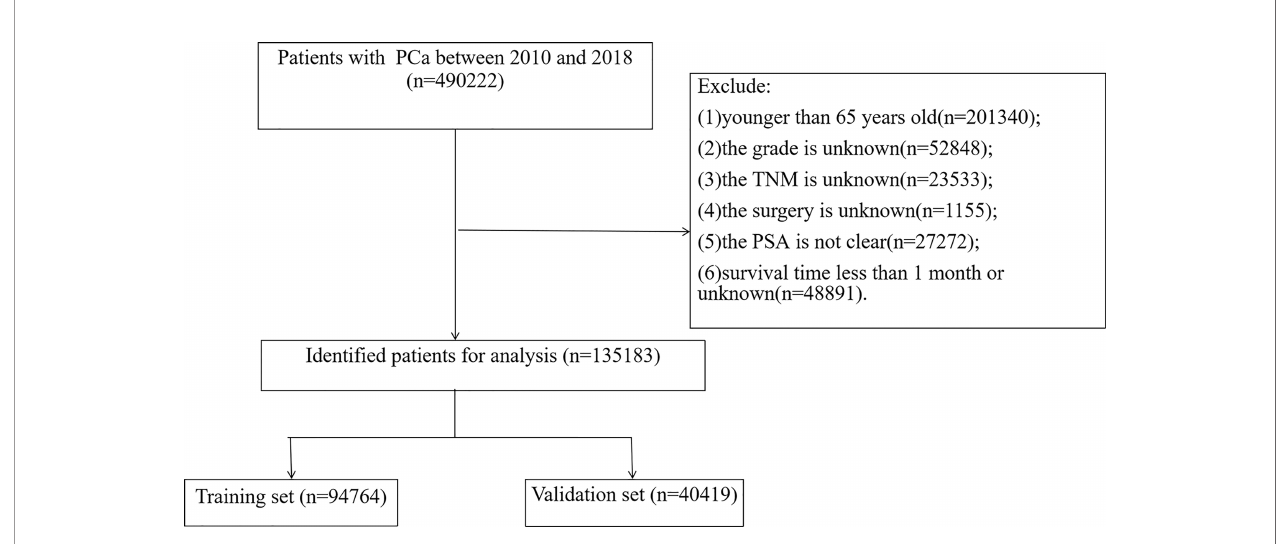
FIGURE 1 | Flowchart for inclusion and exclusion of elderly patients with